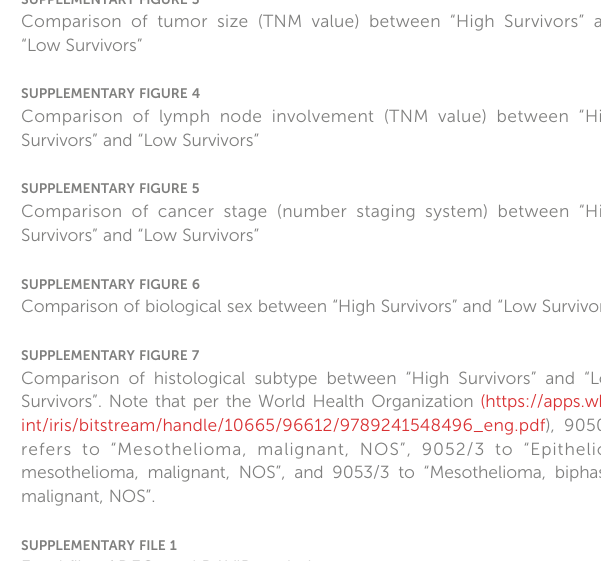
SUPPLEMENTARY FIGURE 2 Comparison of metastatic state (TNM value) between “ High Survivors ” and “ Low Survivors ”